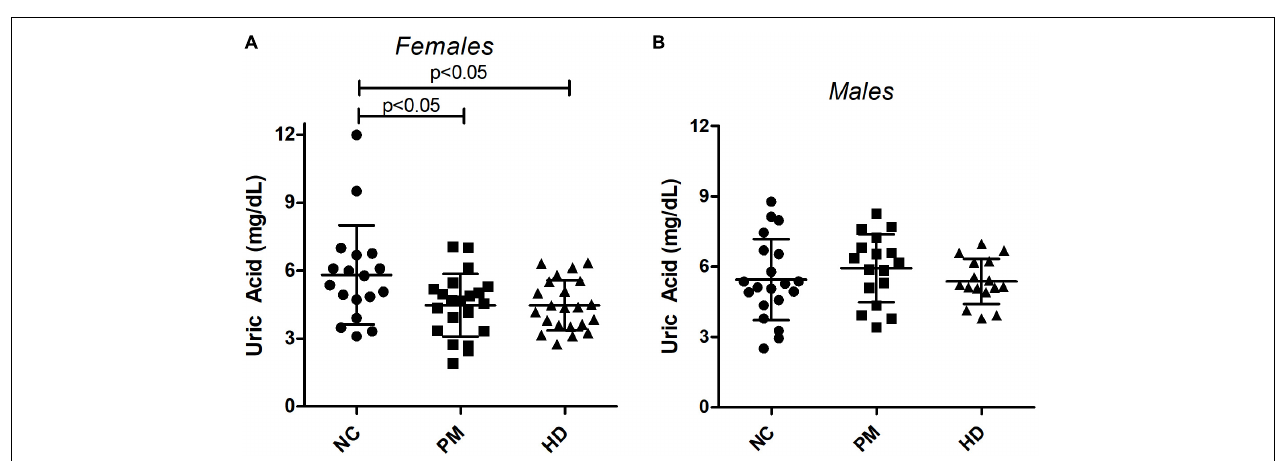
FIGURE 1 | Gender and age effects of uric acid (UA) in plasma from Huntington’s disease (HD) patients and normal controls (NC). (A) Significant differences in gender were determined by Student’s t -test, unpaired; two-tailed; p < 0.0001. The HD patients include pre-HD (PM) and manifest HD patients. (B) Plasma UA levels were not significantly associated with age in any group.